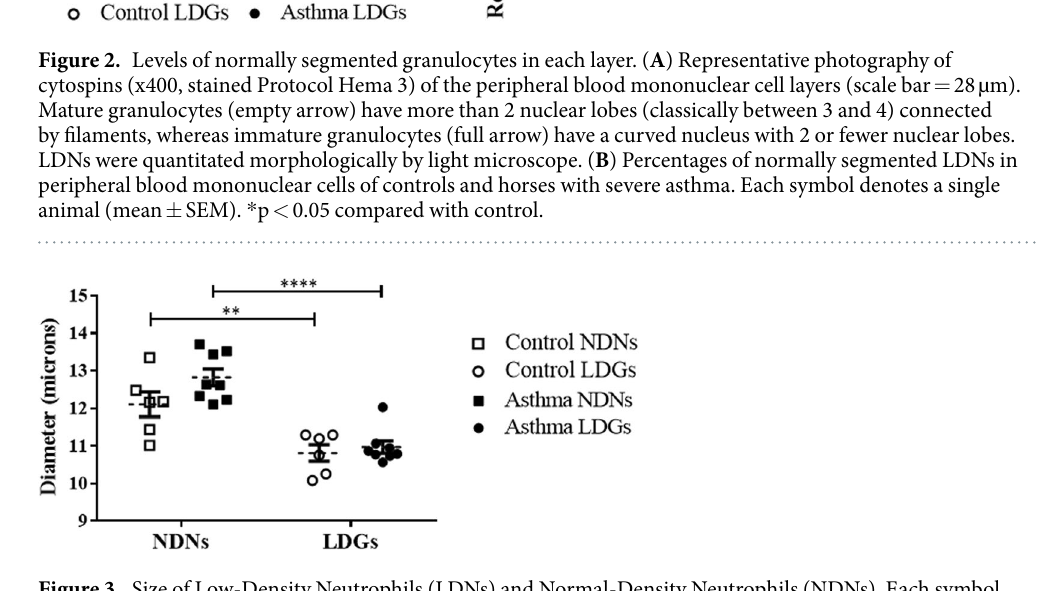
Figure 3. Size of Low-Density Neutrophils (LDNs) and Normal-Density Neutrophils (NDNs). Each symbol denotes the size (diameter) mean for a single horse, and the mean ± SEM for each studied population is shown. ** p ≤ 0.01 and **** p ≤ 0.0001.